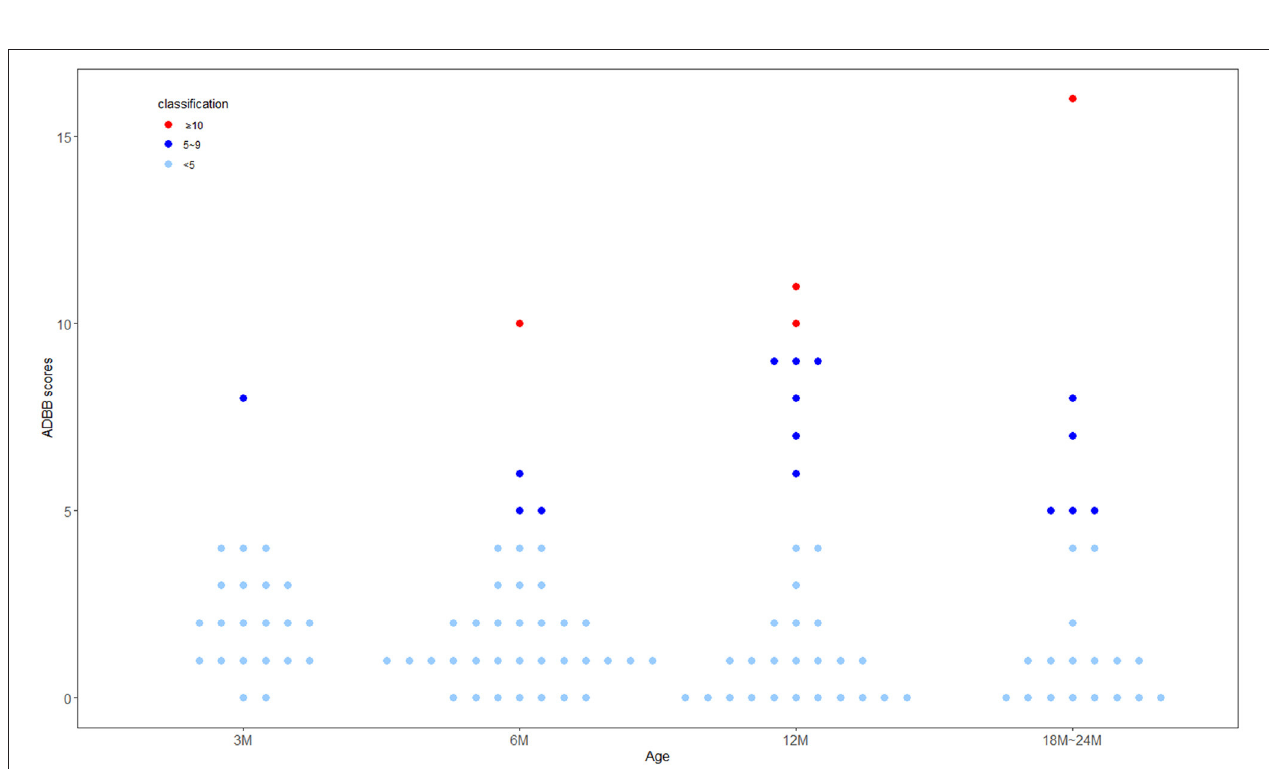
FIGURE 2 | Distribution of the alarm distress baby scale (ADBB) total score by age ( N = 114).